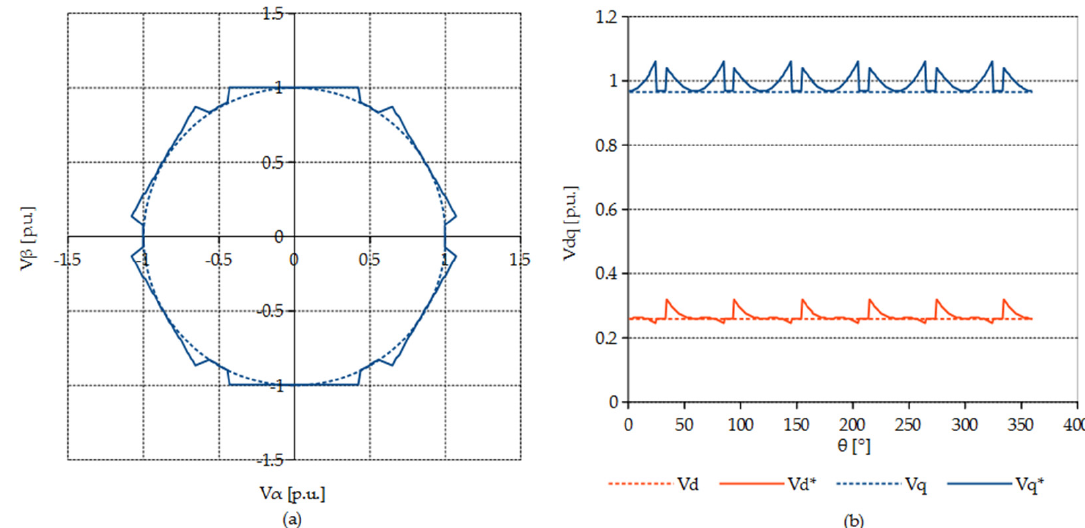
Figure 5. Deformation of the voltage vector caused by the pulse length limiting set to 5% of the duty cycle at a load angle of 15°; the reference voltage components are denoted by an asterisk. ( a ) stationary αβ reference frame; ( b ) synchronous dq reference frame.